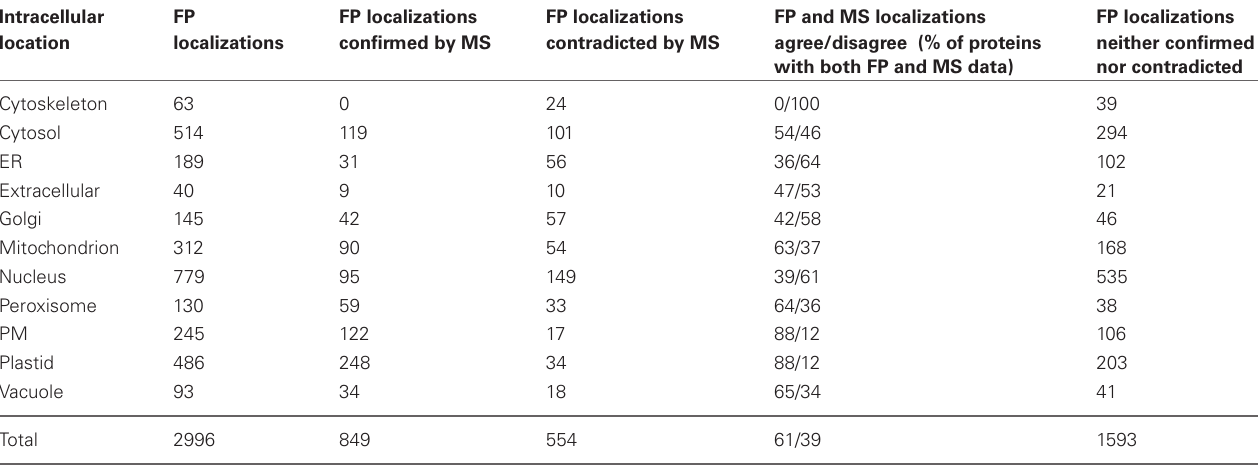
Table 1 | Number of localizations by FP tagging for each of the 11 subcellular compartments in SUBA3.